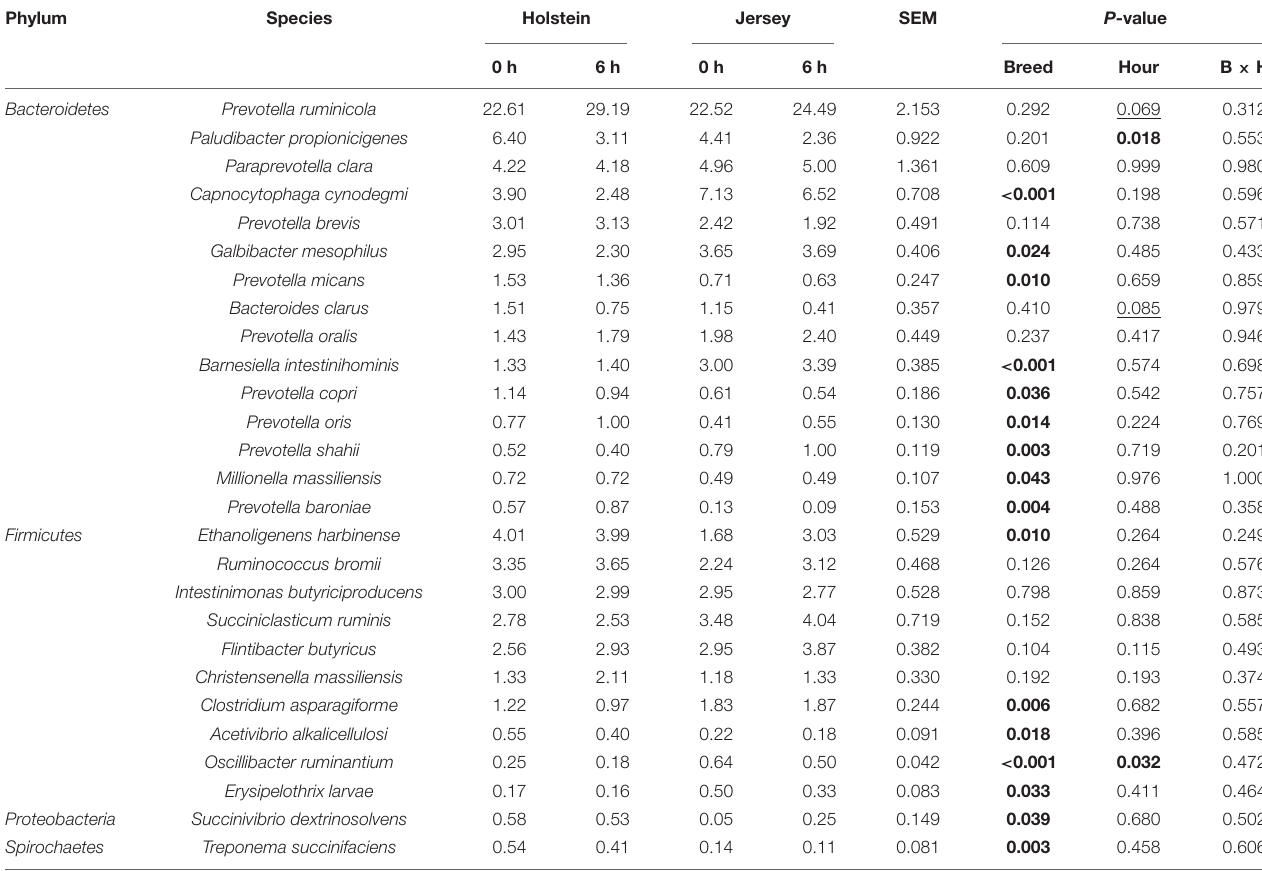
TABLE 5 | Major species of bacteria (each having relative abundance ≥ 1%) and the species that both had relative abundance ≥ 0.5% at least in one breed and at one sampling hour and differed between the two breeds. Phylum Species